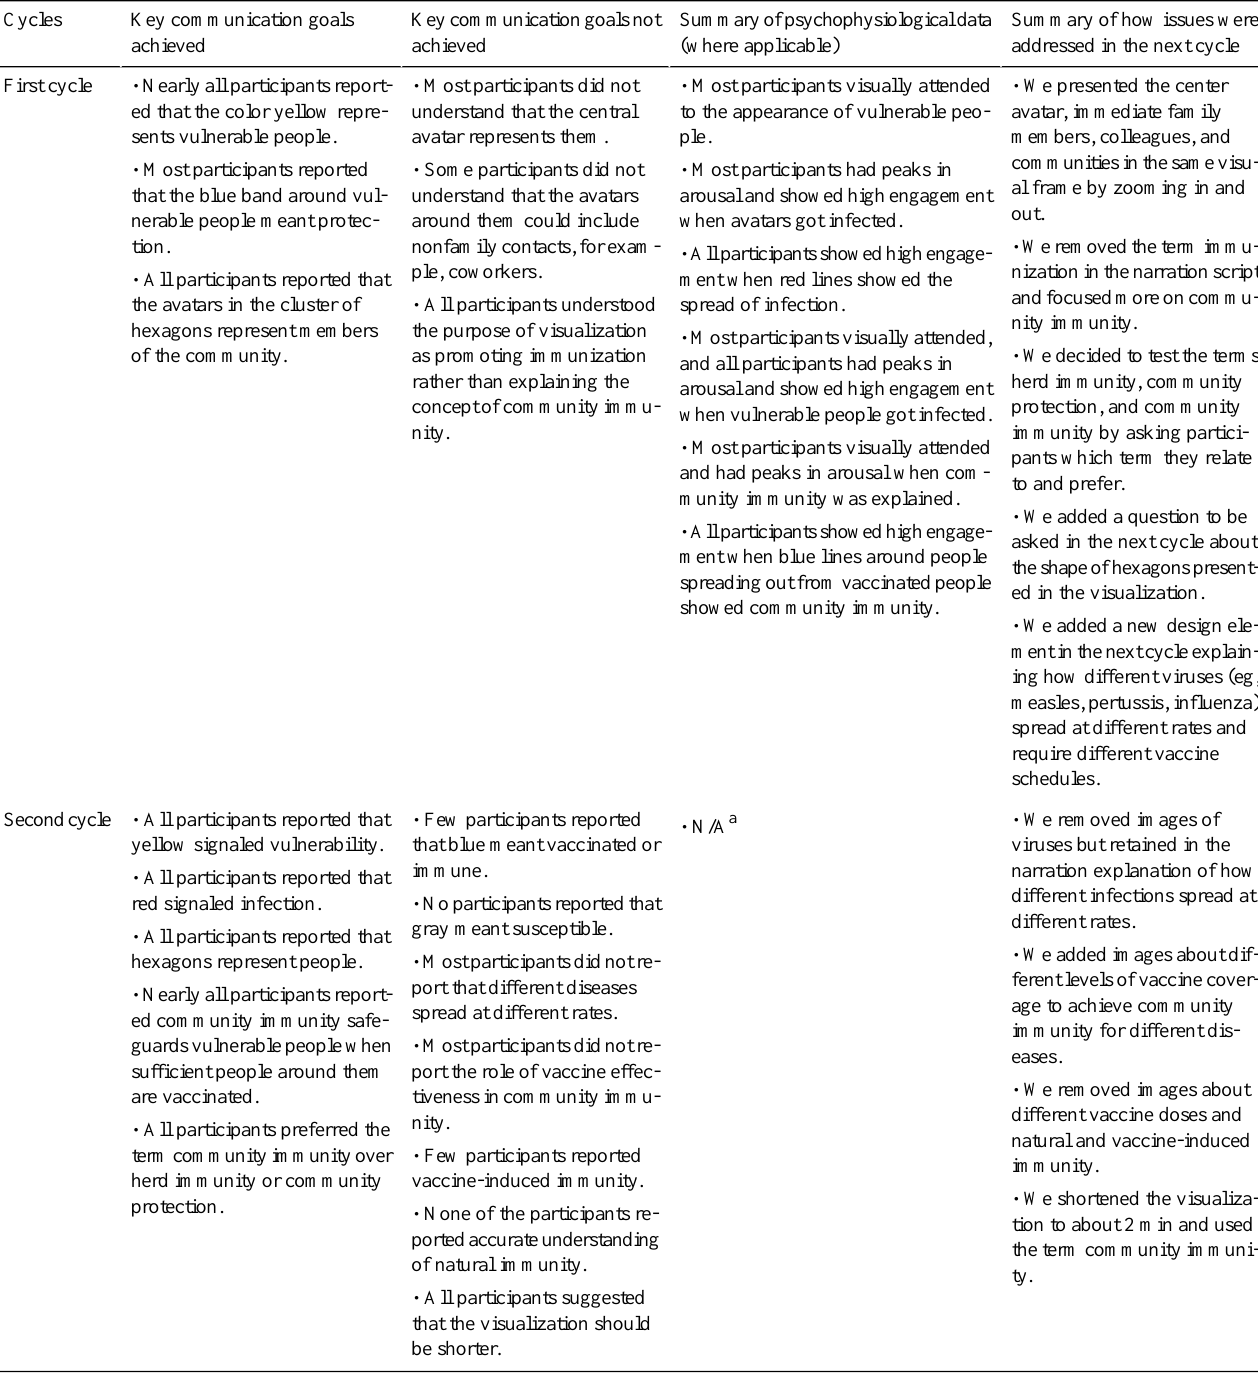
Table 4. Key findings of all cycles.